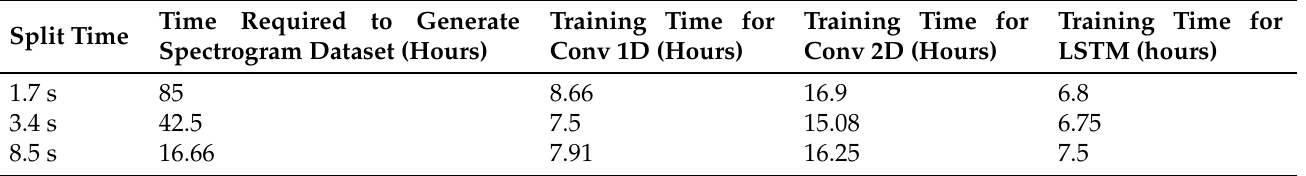
Table 11. Time required for signal envelop function.